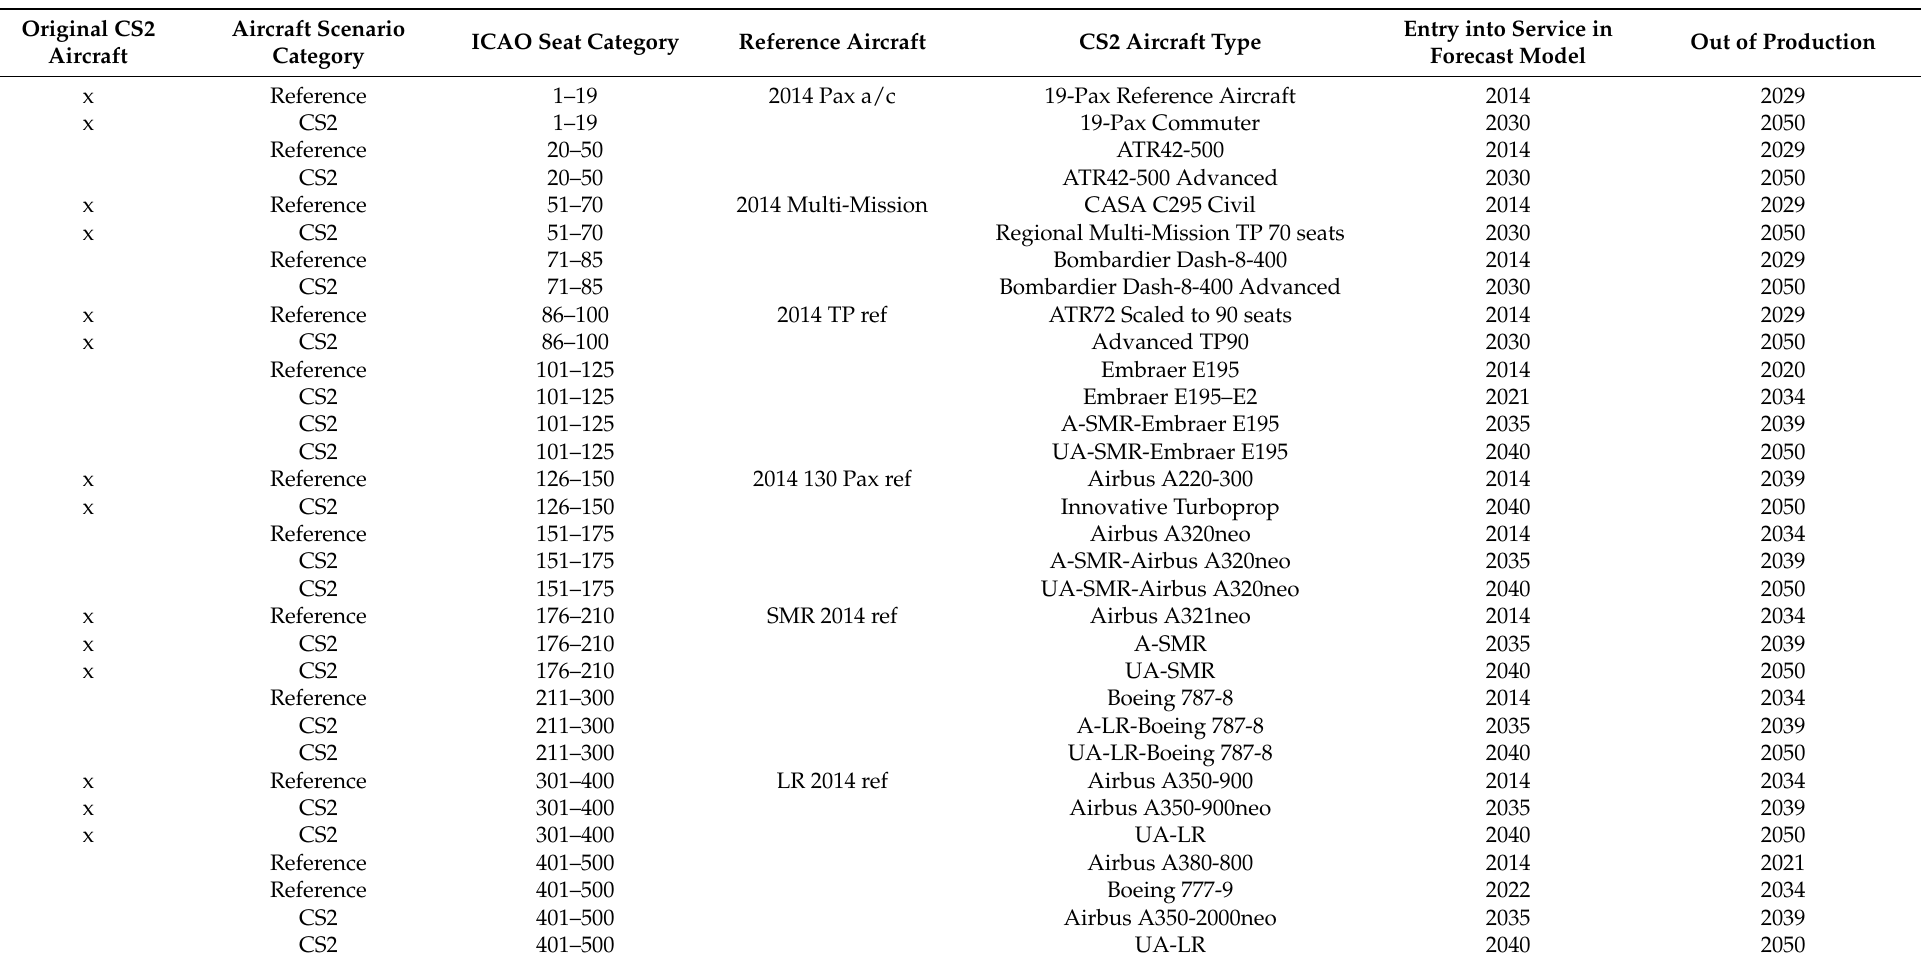
Table 5. Overview of the CS2 Scenario aircraft and the in-production